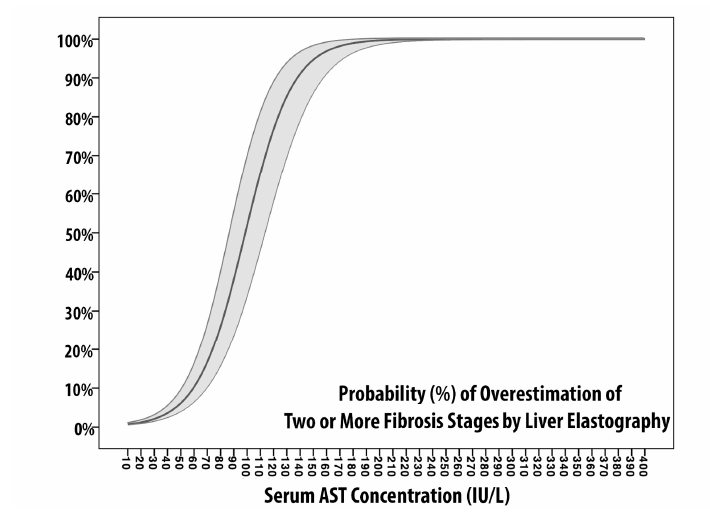
Figure 2. Probability plot of Models 2. The two figures represent the probability of overestimation of two or more fibrosis stages by liver elastography measurement according to serum ALT (left) and serum AST (right). Logistic regression coefficients of probability are represented with 95% confidence intervals (light gray